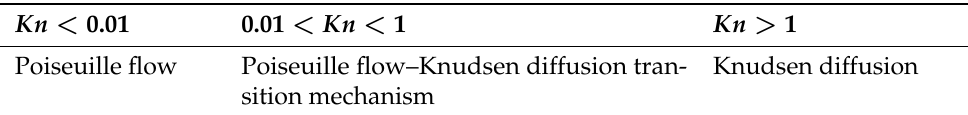
Table 2. Mass transfer mechanisms in membrane pore.